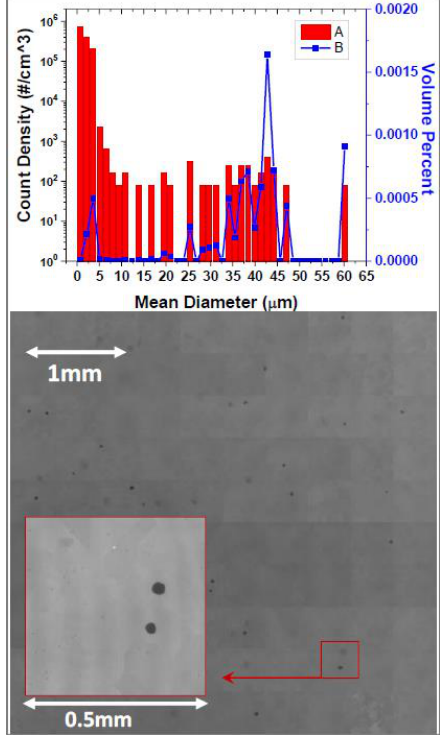
Figure 5. CRY-3, 5 × 5 mm 2 sample; ( top ) Te inclusions with average density ~1.3 × 10 5 cm −3 and size ~1.6 µm. ( bottom ) 2d-IR image with an inset showing 2 large inclusions.